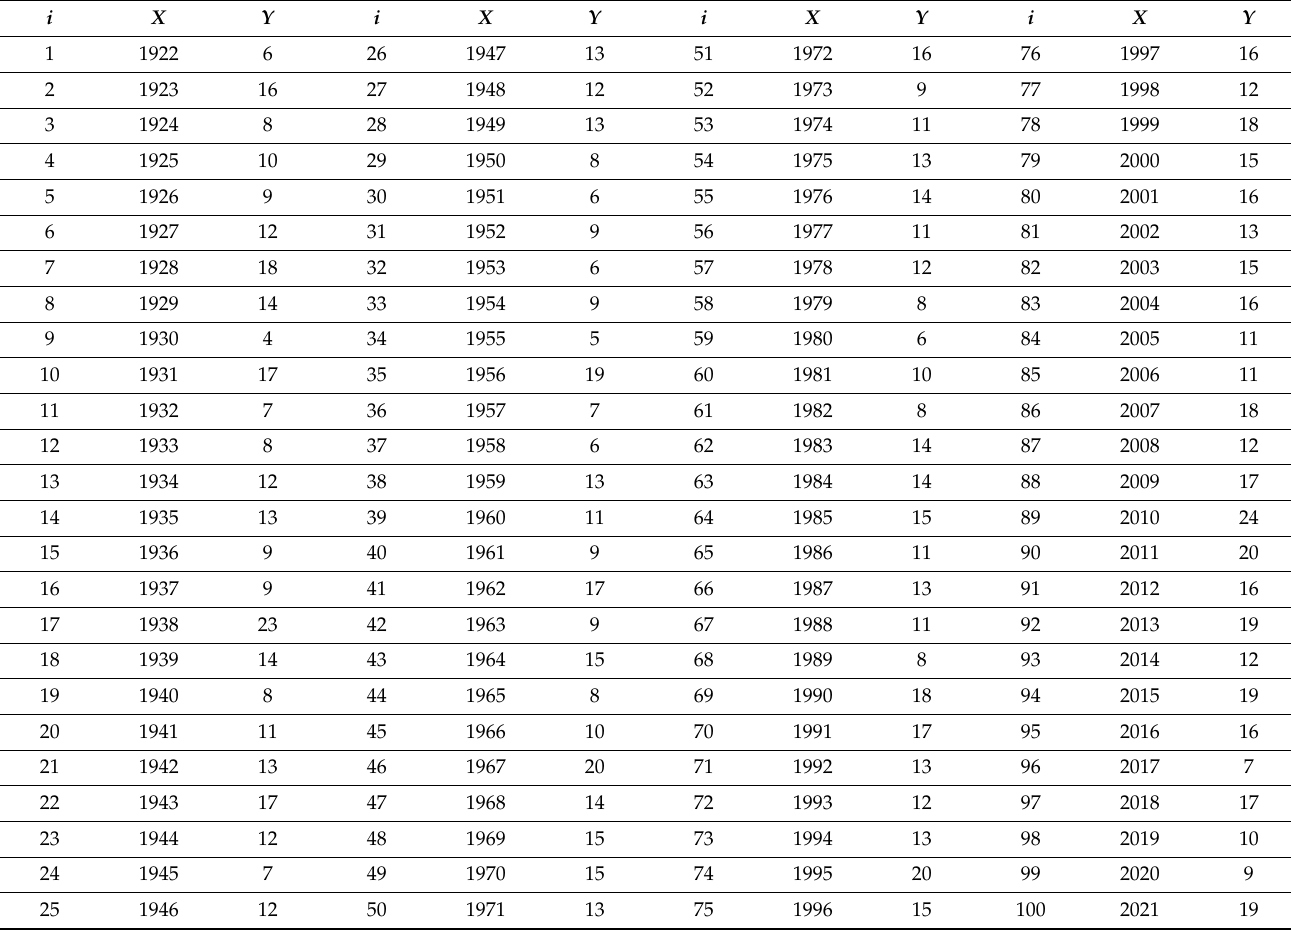
Table 5. Quantity of earthquakes of magnitude 7 or higher by